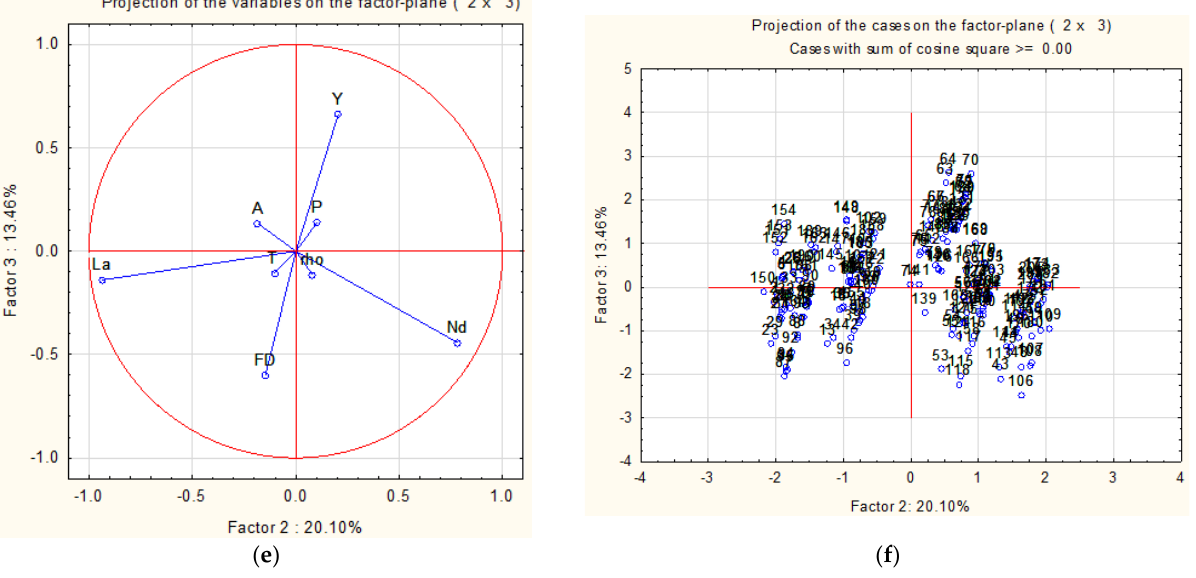
Figure 9. PCA adding Fractal Dimension (FD) computed on images processed with Canny Detection plugin; ( a ) variables plot in PC1-PC2 projection plane, ( b ) Scores plot in PC1-PC2 projection plane, ( c ) variables plot in PC1-PC3 projection plane, ( d ) Scores plot in PC1-PC3 projection plane, ( e ) variables plot in PC2-PC3 projection plane, ( f ) Scores plot in PC2-PC3 projection plane. The amount of variability covered by the first 3 PCs in the data decreased to 78%.